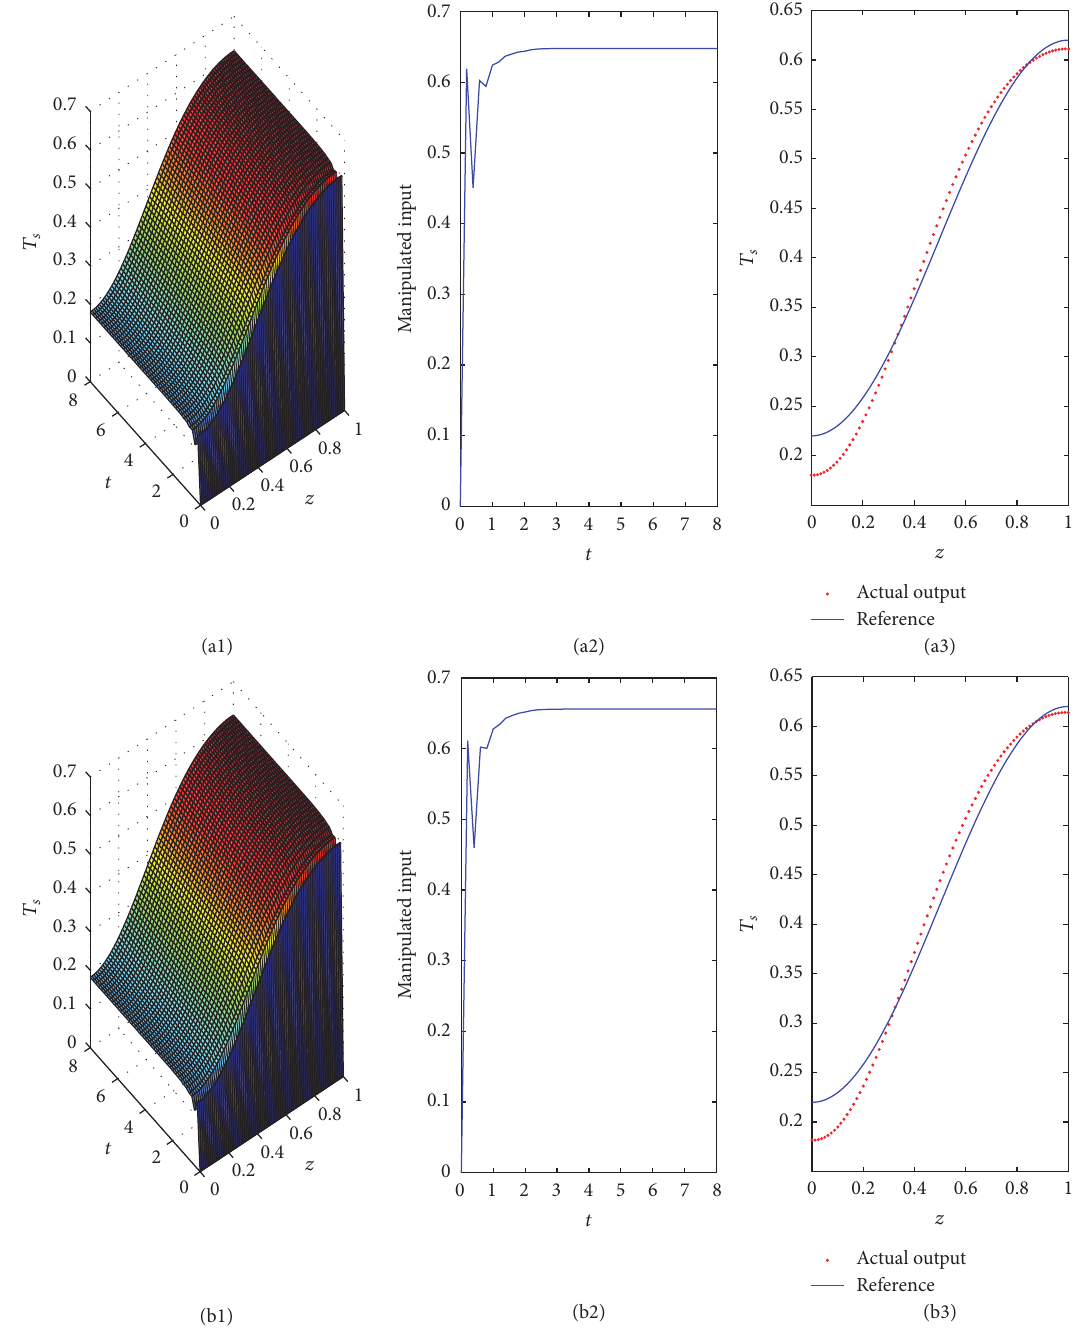
Figure 7: Control performance comparisons with different sensor placement schemes: (a1)–(a3) using proposed sensor locations (eight optimal locations); (b1)–(b3) using eight evenly distributed sensor locations. ( ∗ 1) denotes catalyst temperature evolution profile, ( ∗ 2) denotes manipulated input signal, and ( ∗ 3) denotes catalyst temperature under steady state, where ∗ may be (a) or (b).